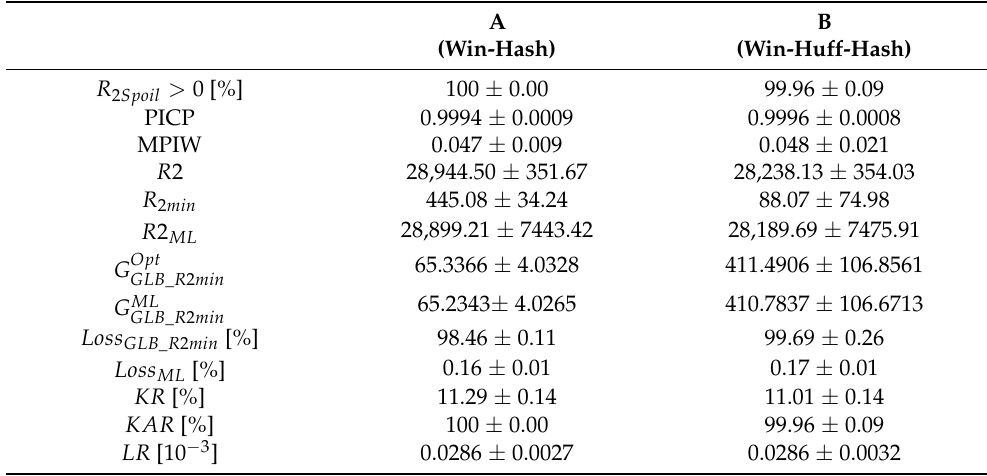
Table 2. Experimental results for two basic systems.